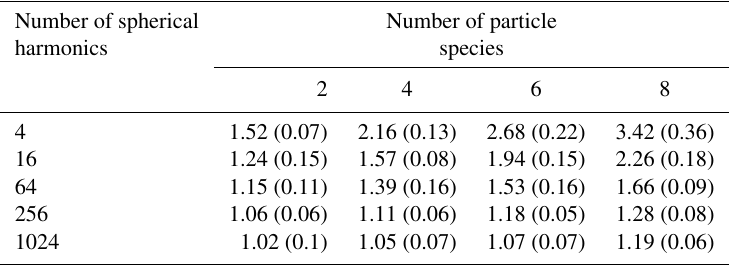
Table B1. The ratio of the computational expense of the SHDOM solution procedure with the new SOURCE function computation for a different number of particle species against the equivalent exact mixture for a varying angular resolution of the SHDOM solver. The media used in the SHDOM solutions are generated from uniform distributions of the effective particle radius, extinction, and single-scattering albedo. The medium has 832 radiative transfer grid points. Half of the particle species in each medium have cloud-sized effective particle radii (10 to 30µm), and the other half have aerosol-sized effective particle radii (0.3–0.5µm). The timing ratios are averaged over 10 stochastic realizations for each configuration, with the standard deviations of the ratios shown in